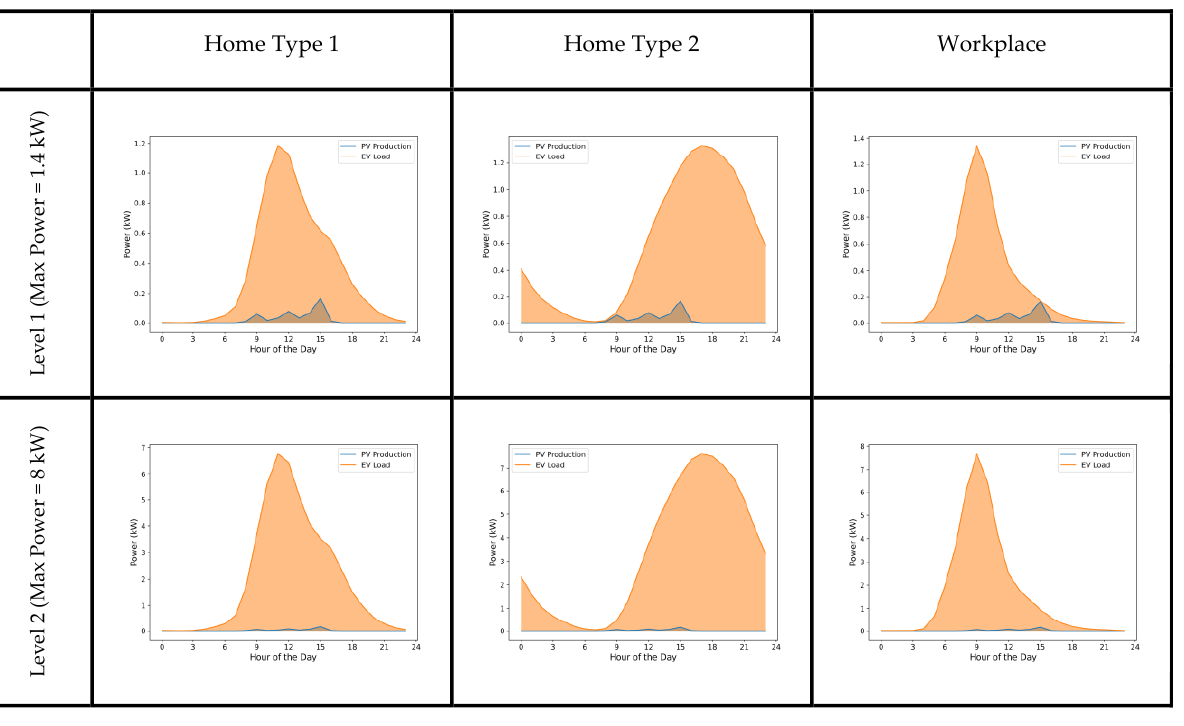
Figure 14. Load-matching results (kW) between the PV system and EV charging stations supplying multiple EVs, using the load profiles proposed by Zhang et al. [66] for a day with minimum energy production (24 December) in London, Ontario. The first two levels of EV charging stations in the North American EV standards are used. Load matching is plotted in different charging locations. In Home Type 1 , the EV users return home at noon.